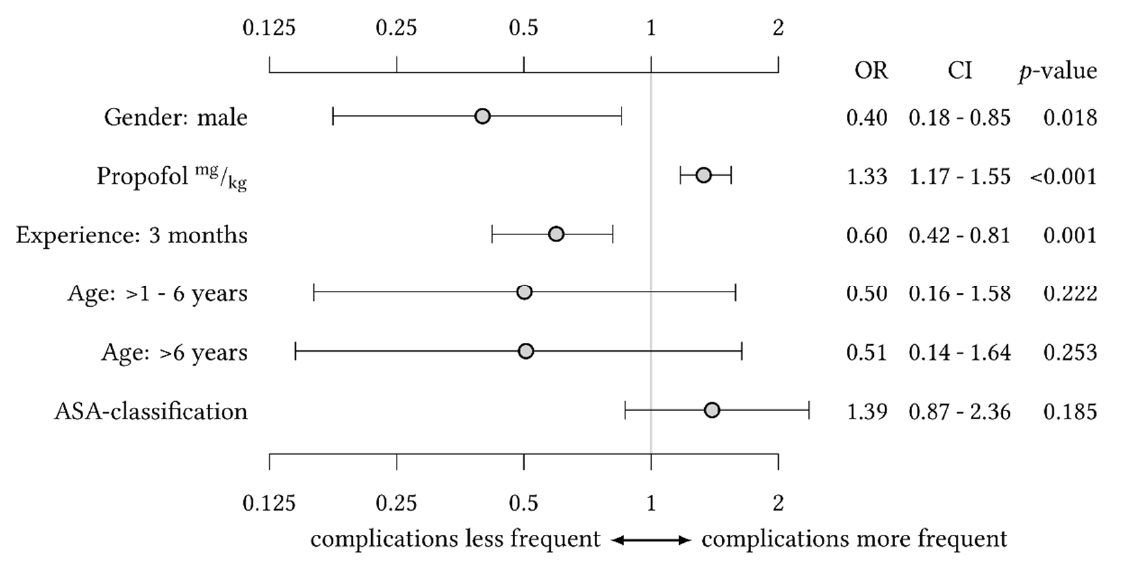
Figure 1. Analysis of variance for the risk of adverse events with gender, sedative agent, and quarter of team experience as independent variables of significant influence and adjustment for age and ASA classification.